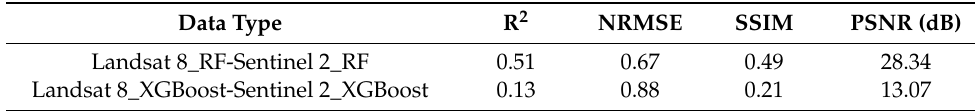
Table 5. Consistency evaluation of different inversion algorithms.